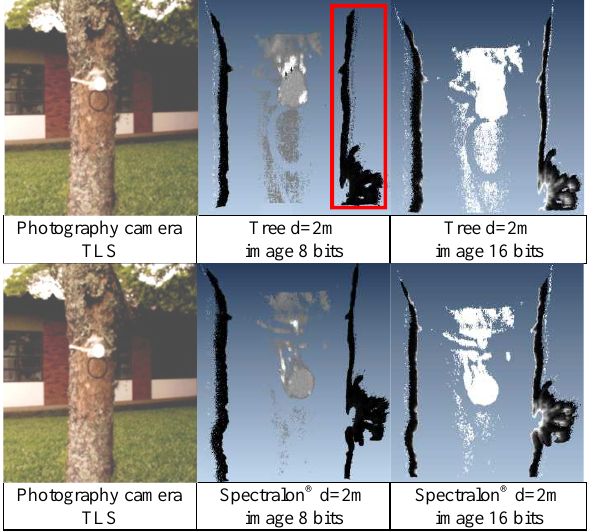
Figure 3. Images produced by the intensity of the TLS in 2m target with 0.5mm spacing between points and radiometric resolution of 8 and 16 bits. Edge effect highlighted in red